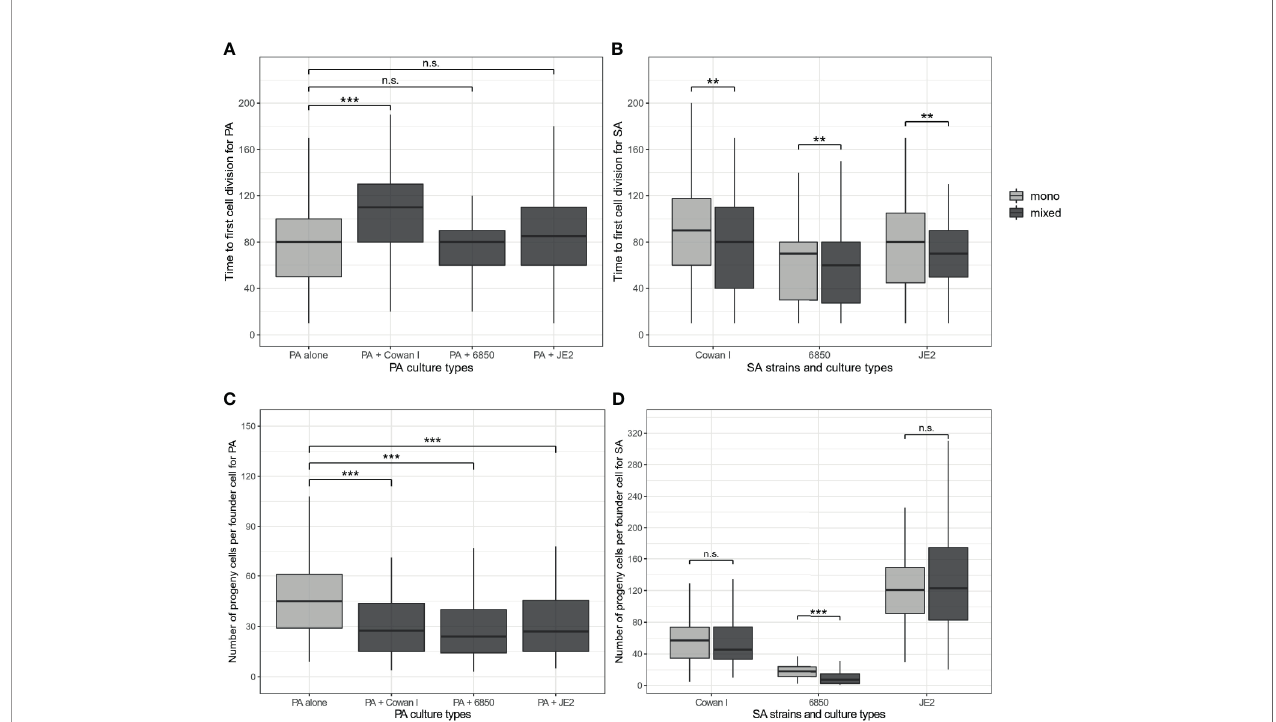
FIGURE 2 | Time of fi rst cell division and number of progenies per founder cell for P. aeruginosa (PA) and S. aureus (SA) microcolonies growing in mono- (light-grey) and mixed culture (dark-grey). (A) Onset of cell division in PA microcolonies is signi fi cantly delayed in the presence of Cowan I, but not affected in the presence of 6850 and JE2. (B) Onset of cell division in SA microcolonies is signi fi cantly accelerated in the presence of PA for all three SA strains. (C) Number of PA progenies is signi fi cantly reduced in the presence of all three SA strains. (D) Number of SA progenies is reduced in the presence of PA for 6850, while the growth of Cowan I and JE2 remained unaffected. The box plots show the median (bold line) with the fi rst and the third quartiles. The whiskers cover the 1.5* inter-quartile range (IQR) or extend from the lowest to the highest value if they fall within the 1.5* IQR. ***p < 0.001, **p < 0.01, n.s., not signi fi cant. Data is from three independent experiments per PA-SA combination, with a total of 352 and 323 microcolonies for PA and SA strains,